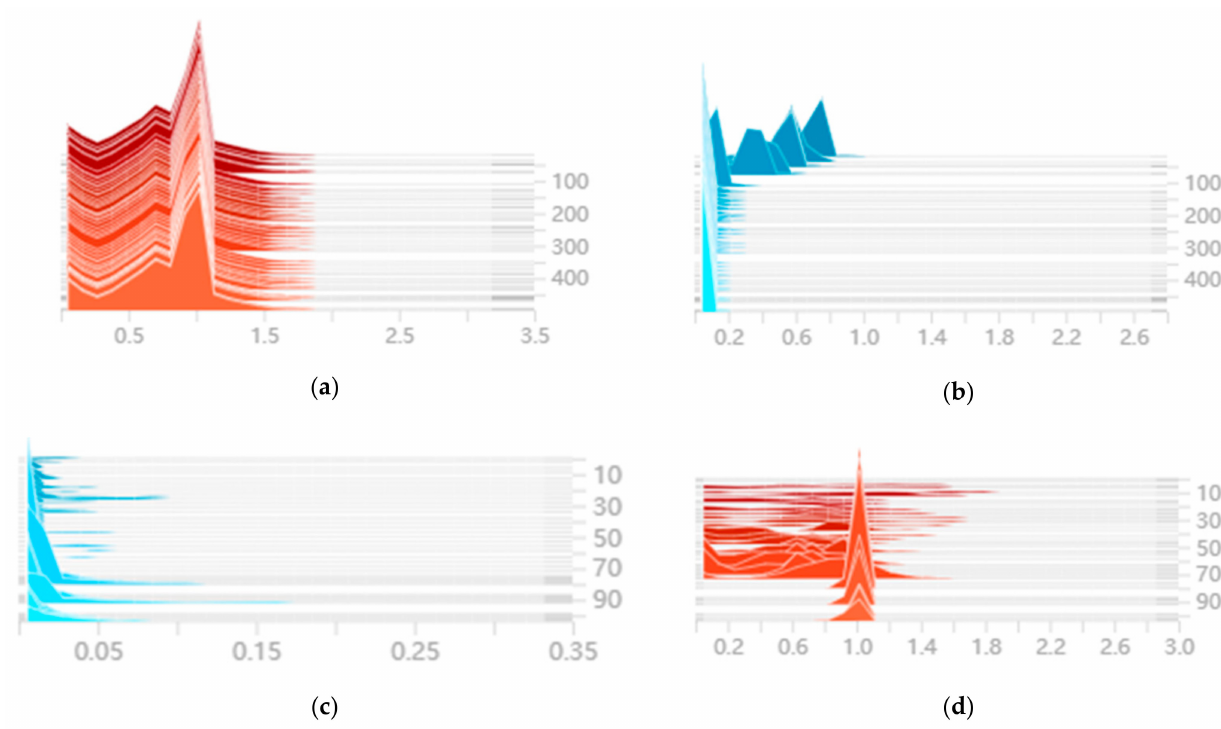
Figure 7. Histogram statistics of scaling factors in all BN layers. ( a ) γ -values for each epoch after base training, ( b ) γ -values for each epoch after sparse training, ( c ) γ -values for each network layer after base training, ( d ) γ -values for each network layer after sparse